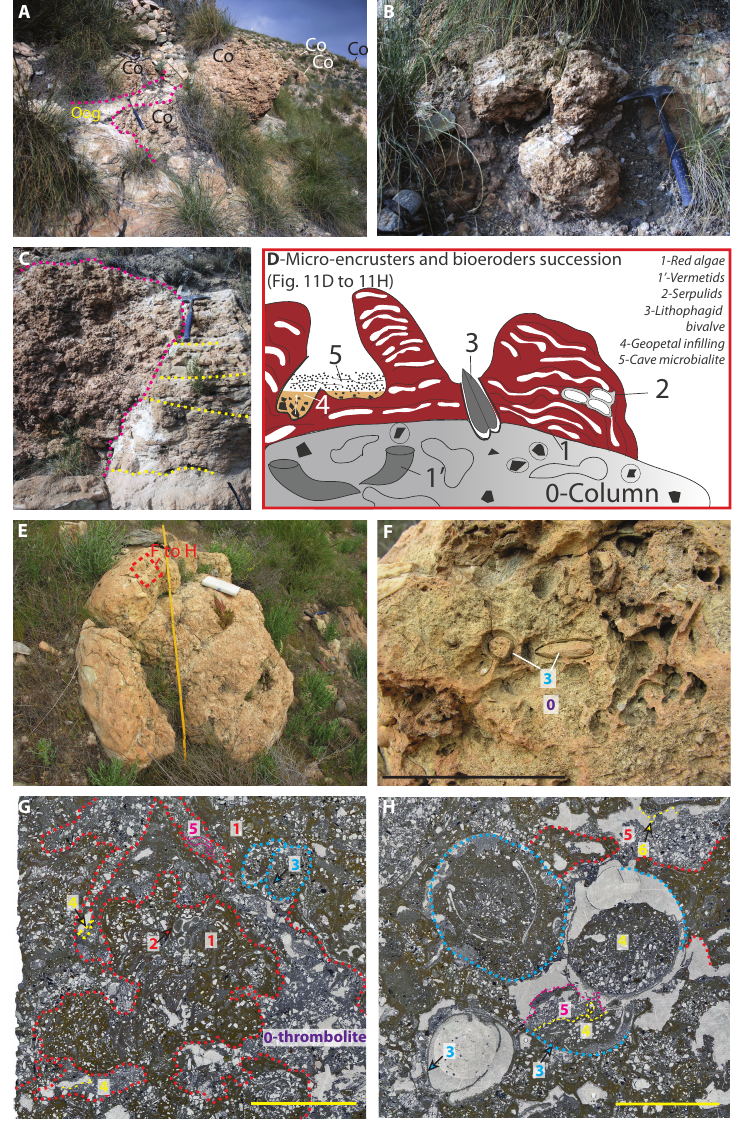
Figure 11. Macro-, meso-, and micro-fabrics of Microbialite Association 2a (MA2a). ( A ) Thrombolitic columns (Co; Table 1) in an ooid shoal grainstone (Oog). Cariatiz, DS2. The hammer is 35 cm long. ( B ) “Mushroom”-shaped column in the same ooid grainstone. Cariatiz, DS2. The hammer is 35 cm long. ( C ) Large column showing a clotted, thrombolitic mesofabric, in an ooid grainstone. The layering of ooid grainstones can be followed inside the columns, indicating that their deposition was contemporaneous with microbialite development. The hammer is 35 cm long. Cariatiz, DS2. ( D ) Sketch of the micro-encruster and bioeroder succession observed in MA2a microbialites. ( E – H ) Succession (0 to 5) of encrusters (red numbers), borers (blue), internal sediment, and cements (yellow) on and inside a thrombolitic crust. Cariatiz, DS3. ( E ) The crust covers a thrombolitic column. The ruler is 1.4 m long. ( F ) The crust (0) is bored by bivalves (3; Lithophaga sp.?). Scale bar is 5 cm. ( G ) The crust (0), showing a calcarenitic microfabric, is encrusted by branching red algae (1) alternating with serpulids (2) and bored by bivalves (3). Red algal and microbialite fabric porosity are filled up with geopetal sediments (4). The inter-branches space is finally filled with a laminated peloidal microbialite crust (5). The scale bar is 5 mm. ( H ) Large borings (3; blue dotted line) are successively infilled with geopetal sediment (4) and a second, cryptic microbialite generation (5; pink dotted line). Finally, a pendant vadose calcite cement (6-Pc) precipitates in the secondary, solution porosity (yellow dotted line). The scale bar is 5